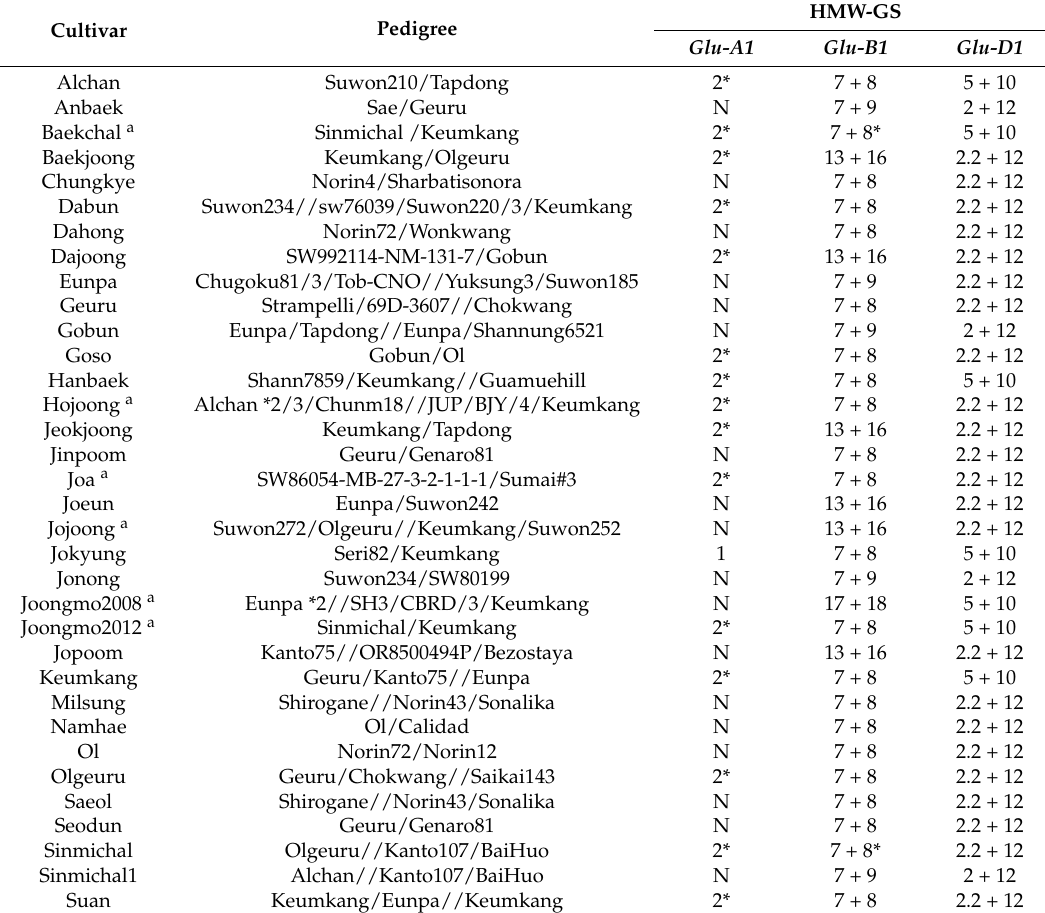
Table 3. Allelic compositions of HMW-GS in Korean cultivars by RP-HPLC. Most cultivars were analyzed previously by SDS-PAGE. Subunits that differed in the two analyses are indicated in bold.